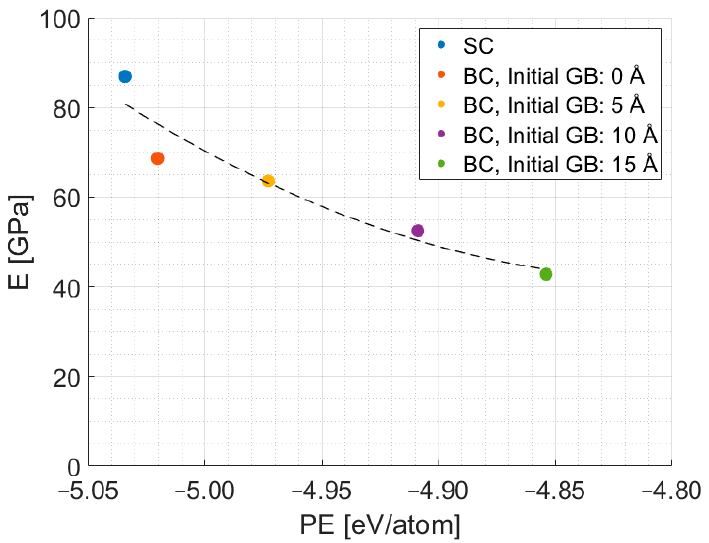
Figure 11. Calculated elastic modulus vs. potential energy of simulation domains.